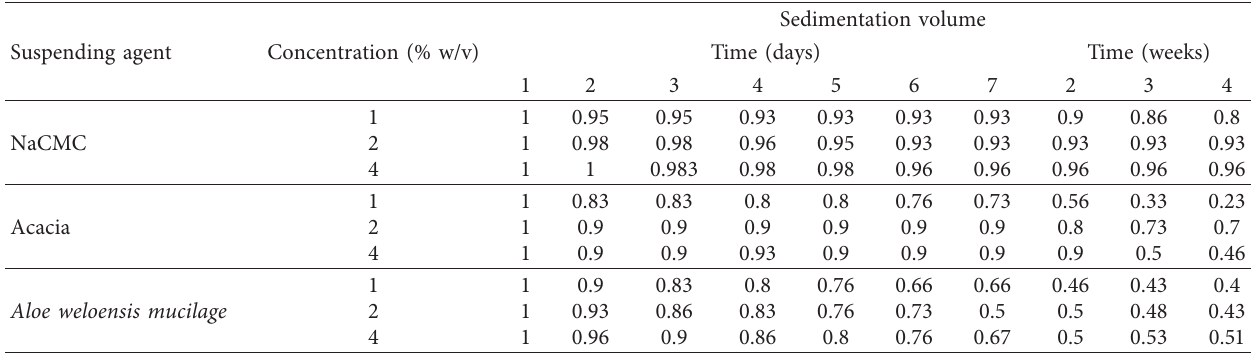
Table 3: Sedimentation volume of ZnO suspensions prepared from Aloe weloensis , acacia, and NaCMC at different concentrations.